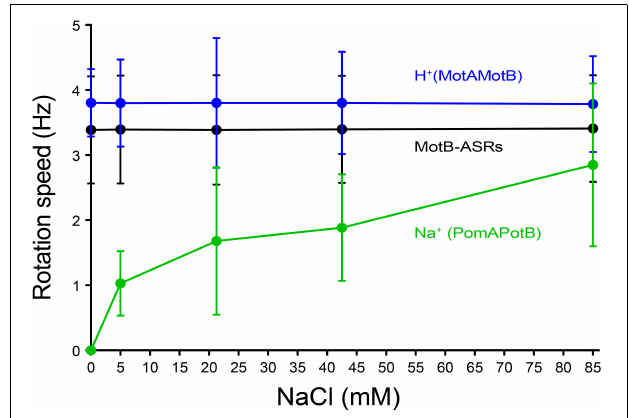
FIGURE 5 | Tethered cell rotational speeds of MotB-ASRs vs. extracellular concentration of Na + . The averaged tethered cell rotation speed (mean ± SD) of all ASR measurements shows no dependency on external sodium concentration. Full data for each ASR is shown in Supplementary Figure 7 . Rotation speed of the sodium powered swimming control (PomAPotB, green) and proton powered swimming control (MotAMotB, blue) are indicated for